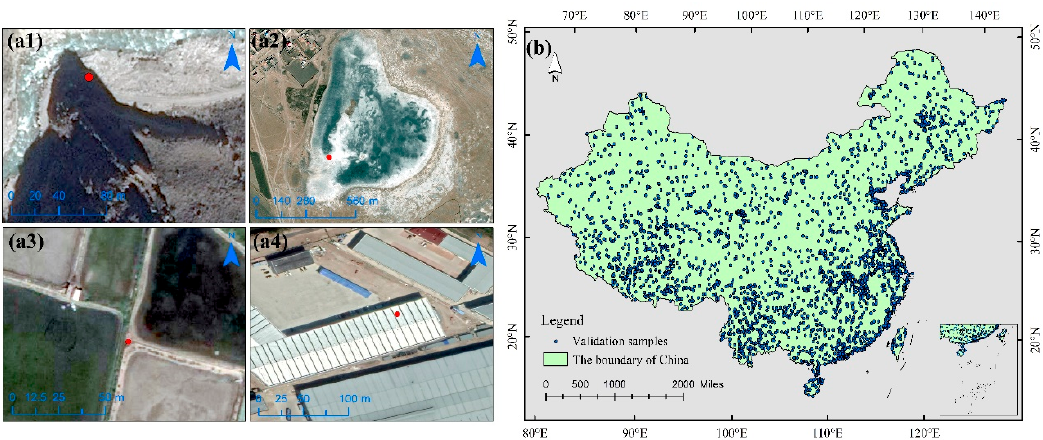
Figure 4. ( a ) Some error sample points from the GSWE water product (( a1 ) mountain shadow, ( a2 ) saline-alkali land, ( a3 ) ridge and ( a4 ) roof); ( b ) China geographic distribution of water samples points. (China boundary layer is from National Administration of Surveying, Mapping, and Geoinformation of China: GS (2016)1569).